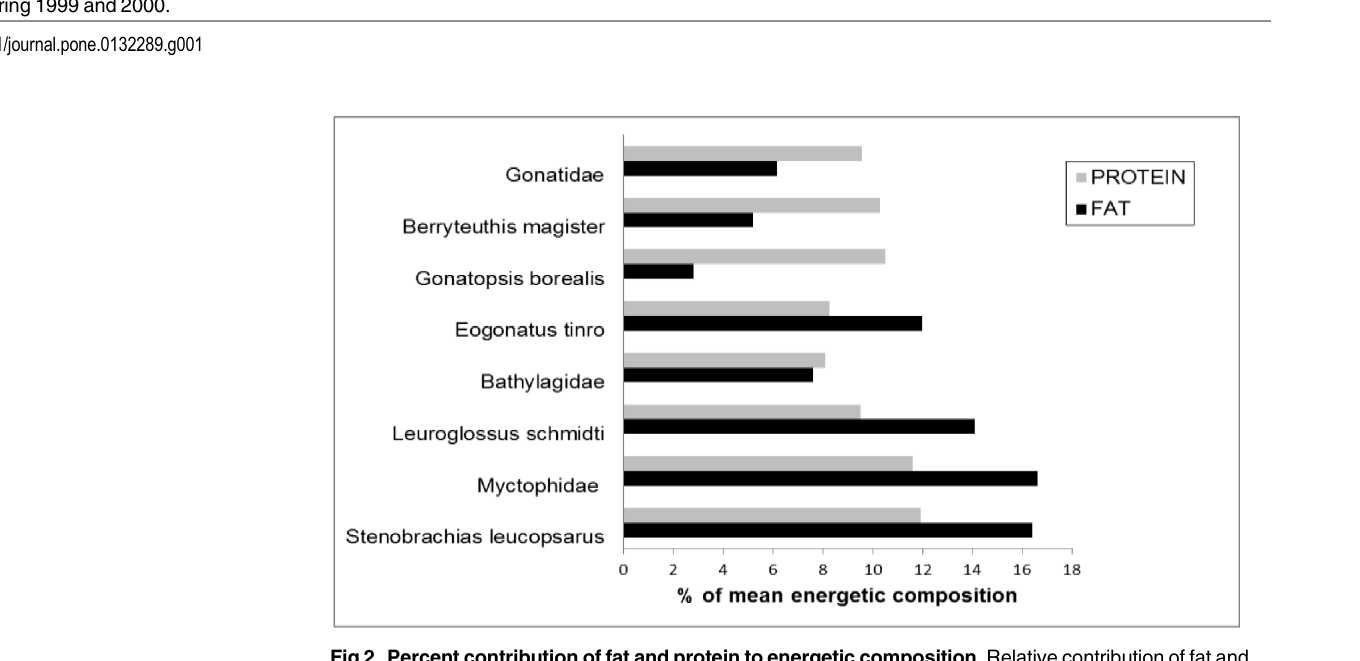
Fig 2. Percent contribution of fat and protein to energetic composition. Relative contribution of fat and protein to energy content of dominant fish and squid families and species caught in Bering Sea research trawls during 1999 and 2000.